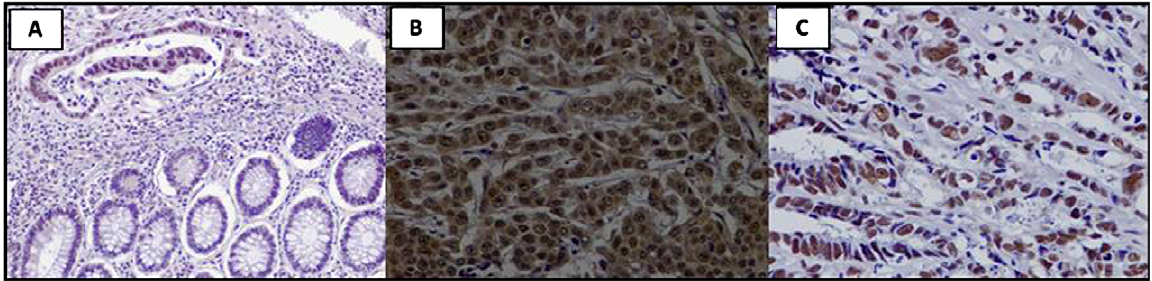
Fig. 6. Survivin protein expression by immunohistochemistry in colorectal carcinomas. (A) Significantly higher nuclear expression of survivin in cancerous tissue (upper part) compared to adjacent normal colonic crypts (lower part) ( × 20). (B) Strong nuclear expression of survivin in a case of colorectal carcinoma ( × 40). (C) A representative case showing both cytoplasmic and nuclear localization of survivin ( × 40). (Colors are visible in the online version of the article;